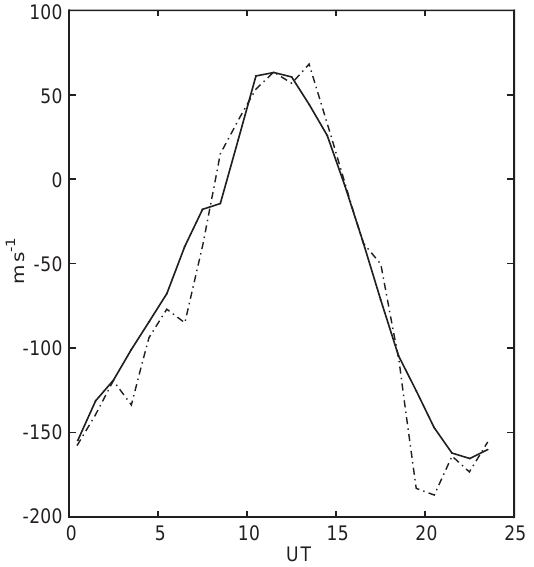
Fig. 3. Comparison between mean wind at 257 km height during high solar activity for two levels of magnetic activity: A and A > 11 in dash-dotted line p